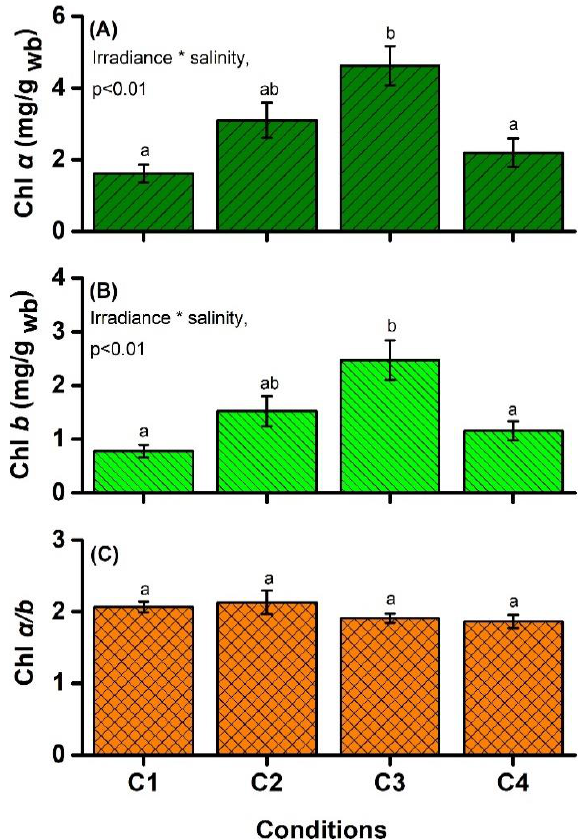
Figure 5. Effects of salinity and irradiance on ( A ) Chlorophyll a , ( B ) Chlorophyll b , and ( C ) Chloro- phyll a/b ratio. Values are means ± standard error and measured on the day 10th of the experiment, n = 6. Wb = wet biomass. For further information see Figures 2 and 3.